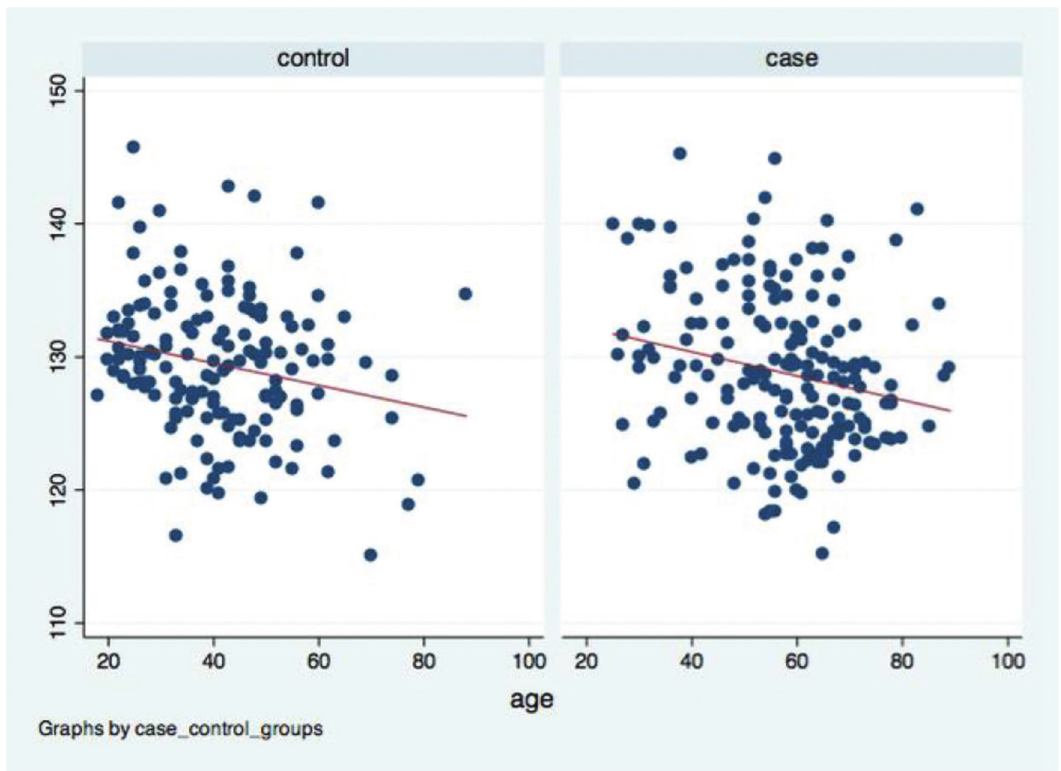
Figure 5 - Dispersion graphic: age versus mean femoral neck–shaft angle. Table 3 - Association of outcomes in cases and control groups versus age.